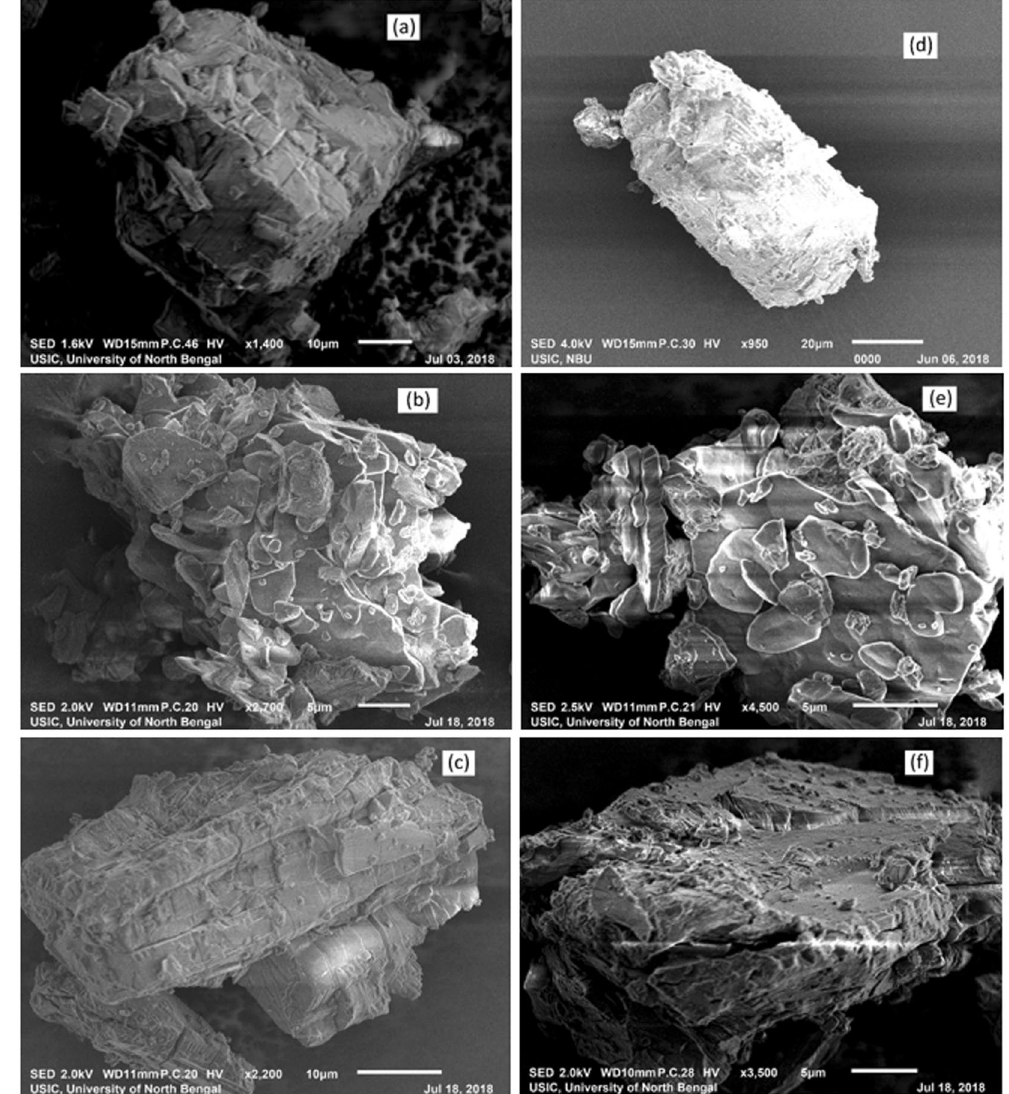
Figure 17. (a , b , c , d , e , f) SEM images of (a) α -CD, (b) (SNP + α -CD) physical mixture, (c) (SNP + α -CD) inclusion complex (d) β -CD, (e) (SNP + β -CD) physical mixture, (f) (SNP + β -CD) inclusion